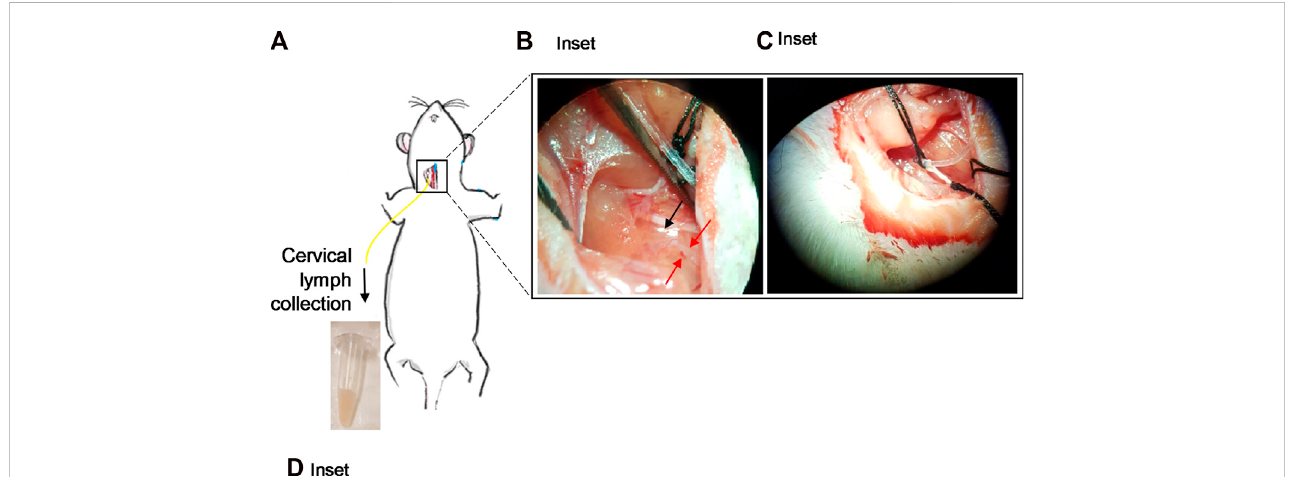
FIGURE 1 Cannulation of the cervical lymphatic duct in an anaesthetized rat. (A) Illustration of an anaesthetized rat showing the surgical site for cervical lymph cannulation. Yellow line represents cannula inserted into the cervical lymph duct. Inset: (B) Separation of the muscles around the cervical lymph duct using straight forceps. Red arrows denote location of cervical lymph duct efferent to dcLN. Black arrow denotes the location of the dcLN. (C) Insertion of the cannula into the cervical lymph duct. (D) Cervical lymph fl uid draining from the cannula is collected into pre-weighed